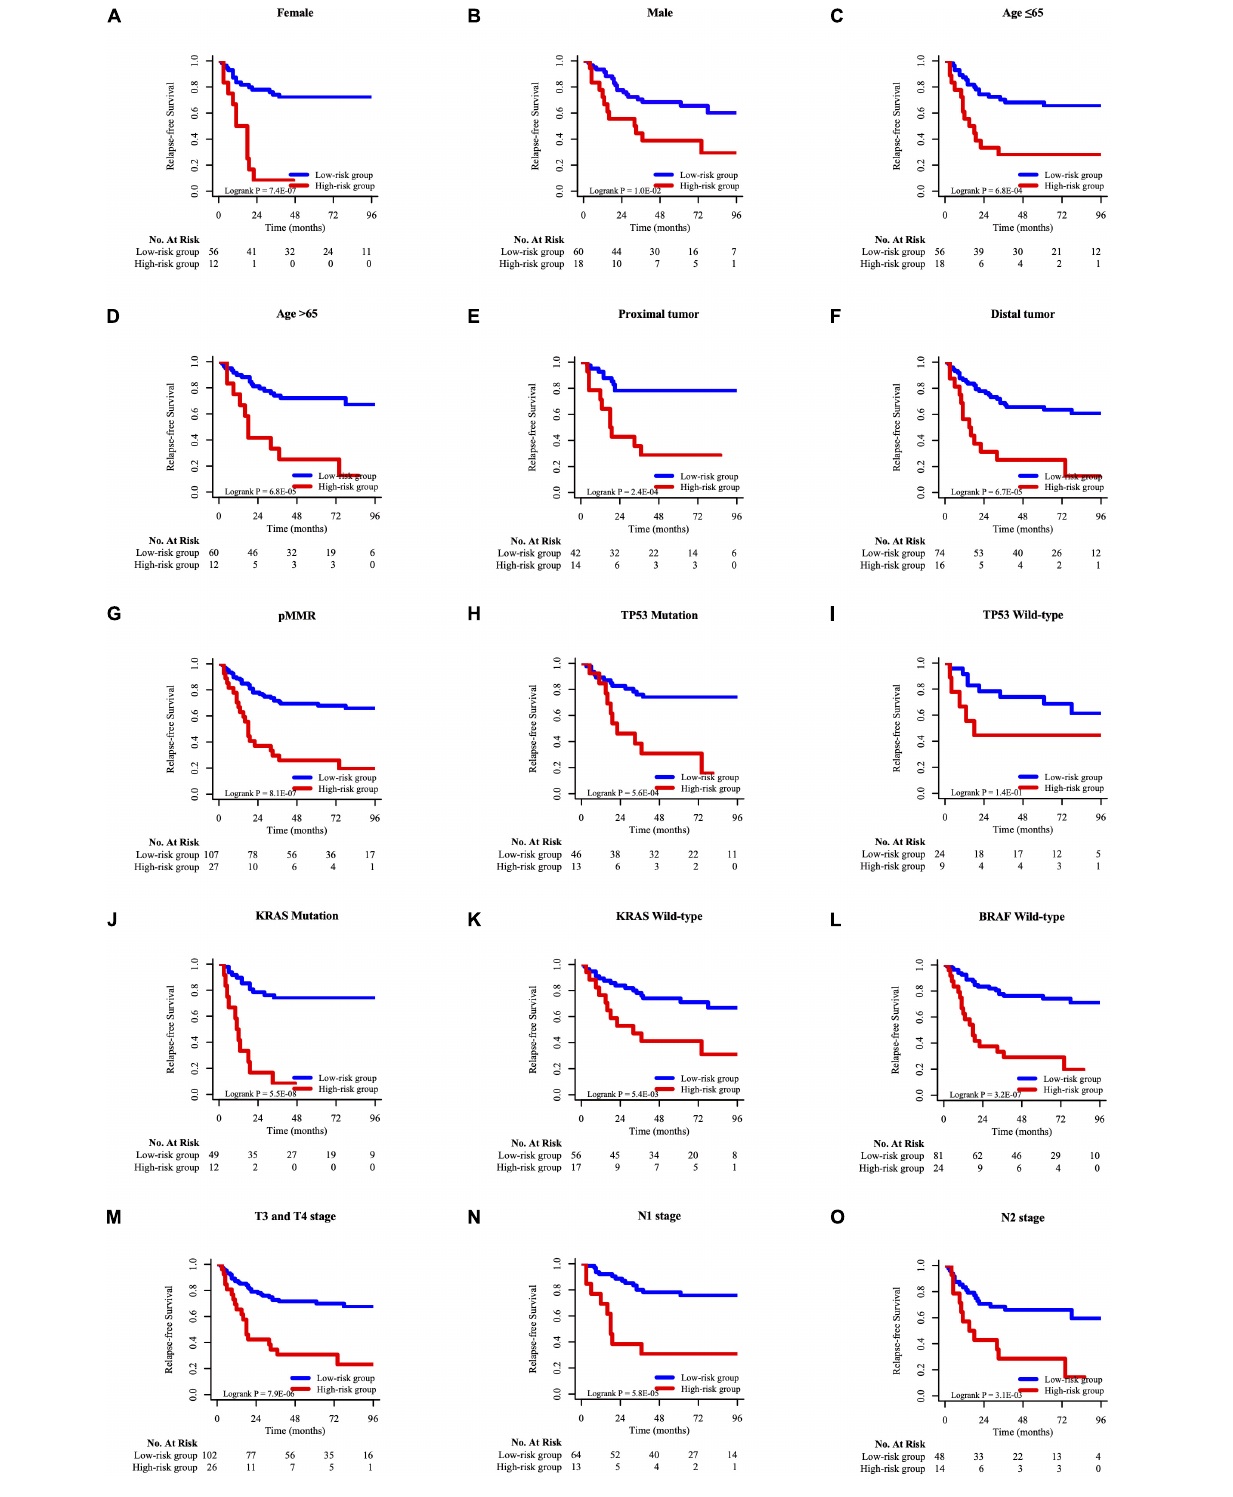
FIGURE 6 | The K–M survival curves of overall survival between high-risk and low-risk group of different clinicopathological features, including gender (A,B) , age (C,D) , tumor site (E,F) , MMR status (G) , TP53 mutation status (H,I) , KRAS mutation status (J,K), BRAF mutation status (L) , pathological T stage (M) , pathological N stage (N,O)